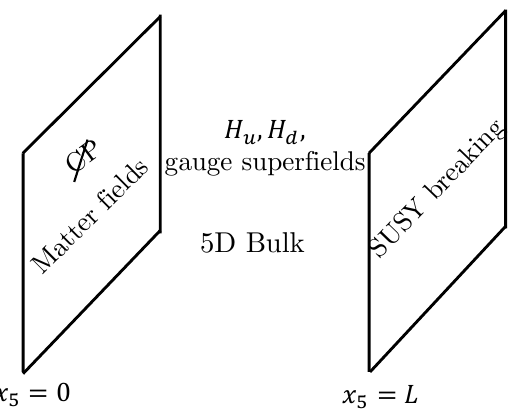
Figure 1 . UV structure of gaugino mediation. Flavored matter fields and Yukawa couplings and CP-violation are localized on the extra-dimensional boundary at x 5 = 0 , while SUSY-breaking dynamics is localized on the boundary at x 5 = L , thereby sequestering SUSY-breaking from flavor- and